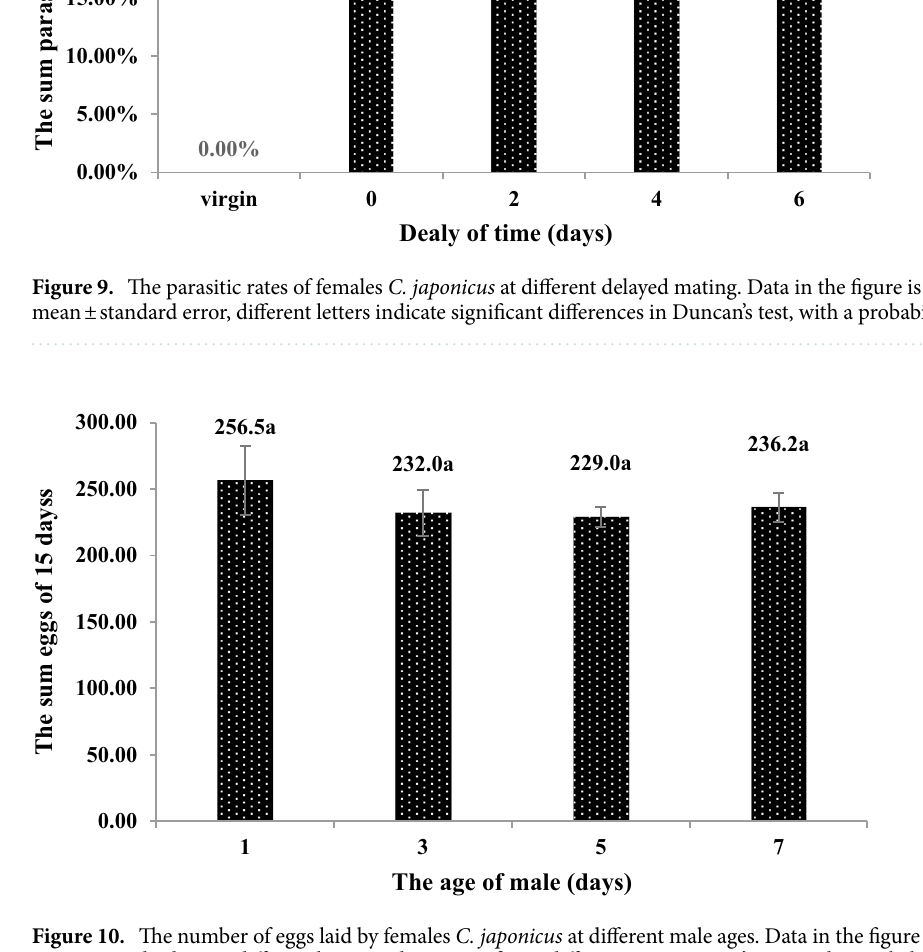
Figure 10. The number of eggs laid by females C. japonicus at different male ages. Data in the figure are mean ± standard error, different letters indicate significant differences in Duncan’s test, with a probability of